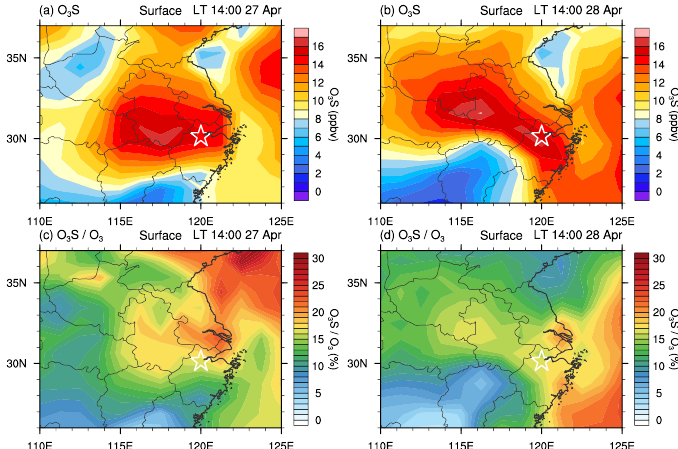
Figure 12. Spacial distribution of the CAM-Chem simulated O 3 S ( a , b ) and O 3 S/O 3 ratio ( c , d ) in eastern China at surface on 27 and 28 April 2018. The white star in each panel indicates the location of